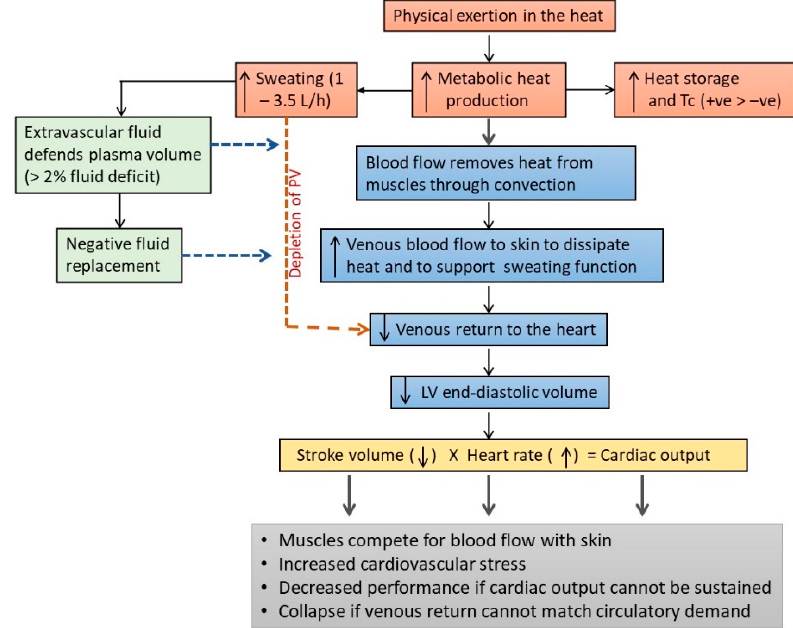
Figure 2. Effects of physical work and exercise on fluid homeostasis and cardiovascular (CVS) functions. Intense physical work can increase metabolic heat production by >10-fold, leading to an increase in heat storage and the activation of the sweating response to dissipate heat. Metabolic heat produced in the muscle is transferred to venous blood and transported to the skin to be dissipated to the environment. The diversion of venous blood to the skin reduces the volume of venous blood returning to the heart, leading to lower stroke volume and a higher stress load on CVS to maintain cardiac output and to meet the demand for muscle blood flow. The increased demand on the CVS is further burdened by the loss of plasma volume (PV) due to sweating, which can range about 1–3.5